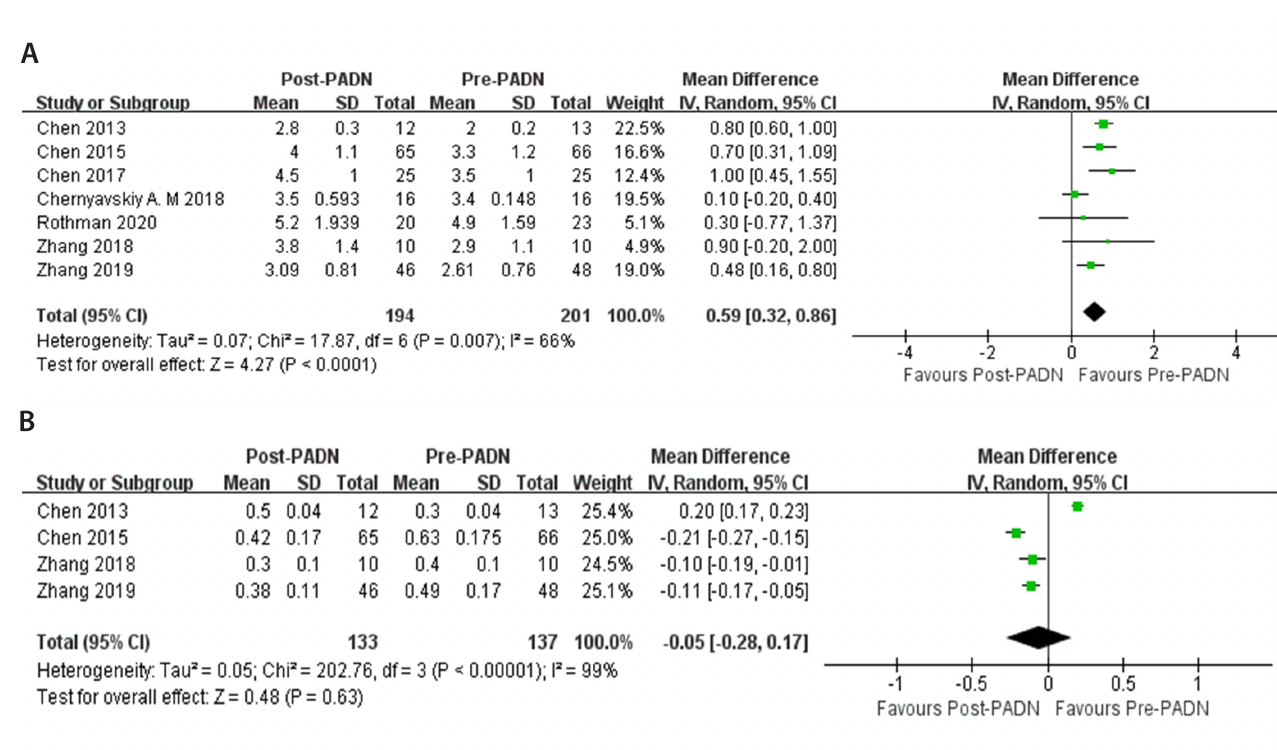
Fig. 4 - Forest plot for comparison of hemodynamic parameters between post pulmonary artery denervation (PADN) period and pre-PADN period: A) cardiac output (L/min); B) right ventricular Tei index. CI=confidence interval; SD=standard